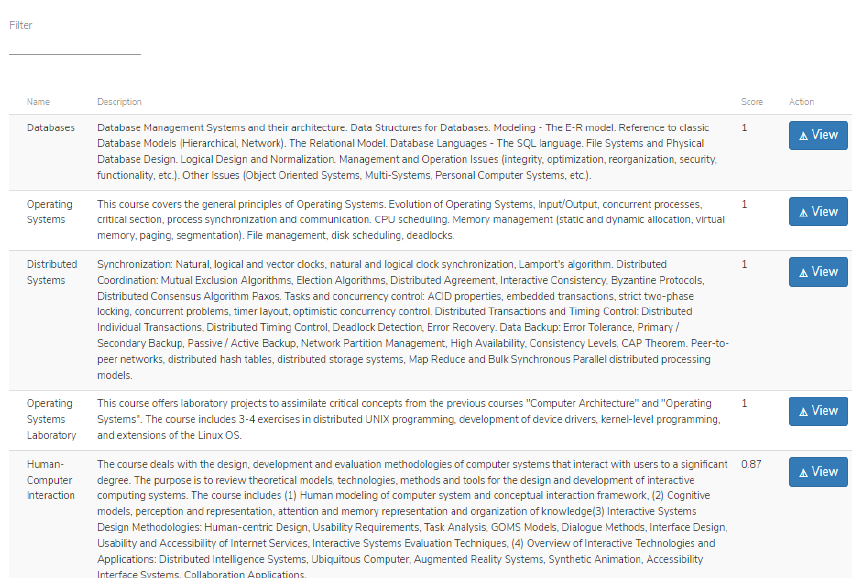
Figure 5. Recommended courses.